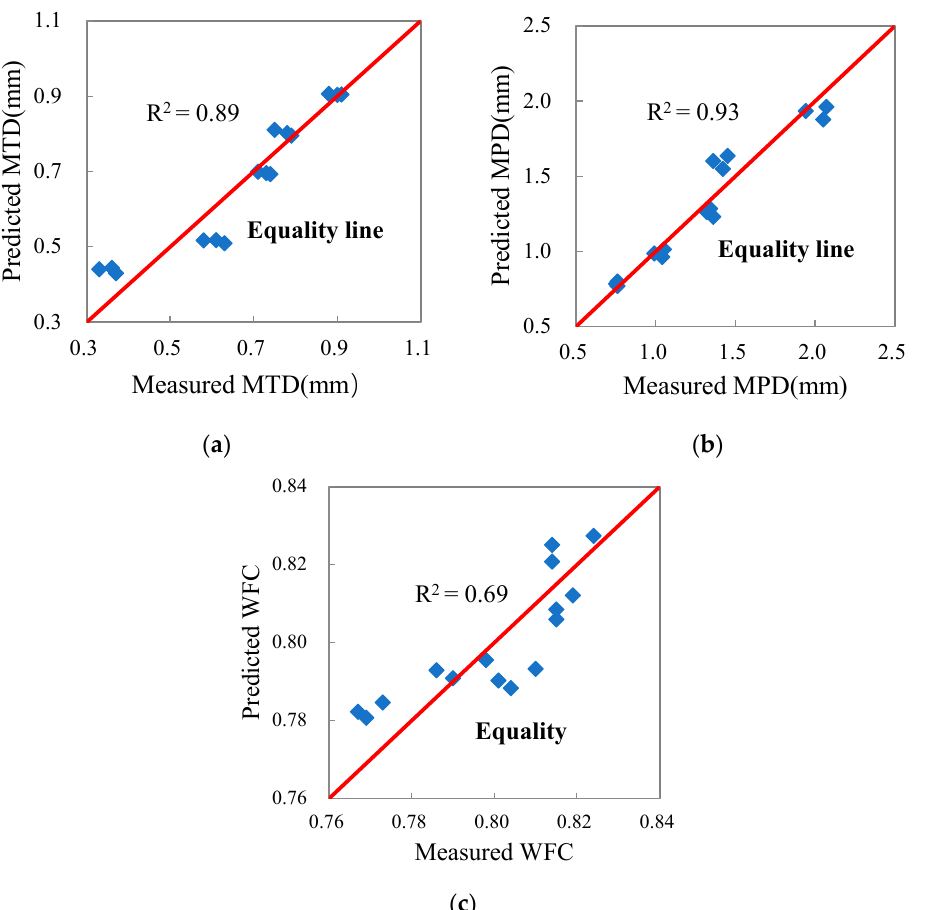
Figure 12. Predicted pavement surface property parameters and measured pavement surface property parameters: ( a ) MTD, ( b ) MPD, ( c ) WFC.